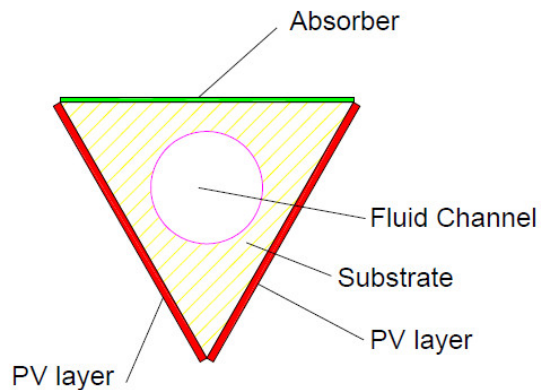
Figure 14. The cross-sectional view of heat receiver tested in [98].